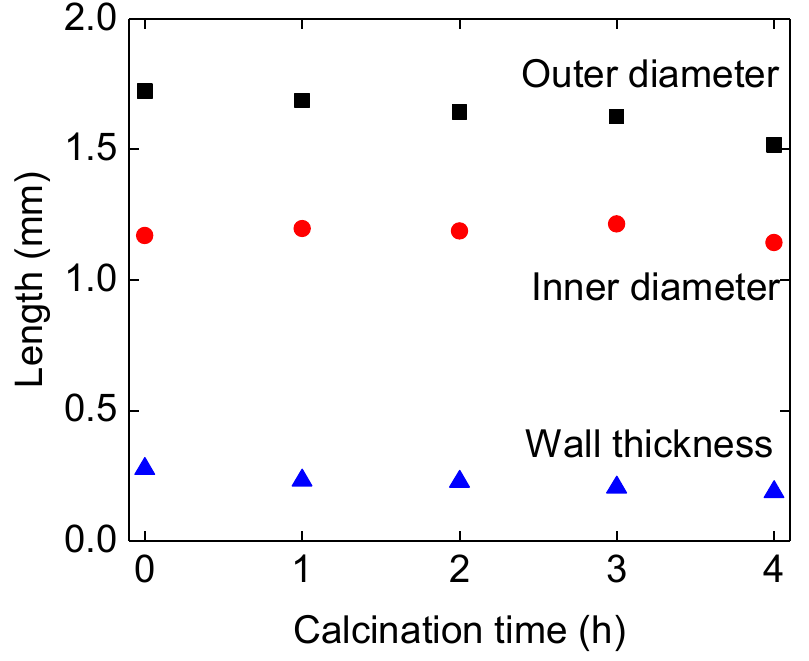
Figure A2. Fiber dimensions as obtained for fibers calcined at 600 ° C for different times. Within the error of measurement, the diameters and wall thickness do not significantly change.